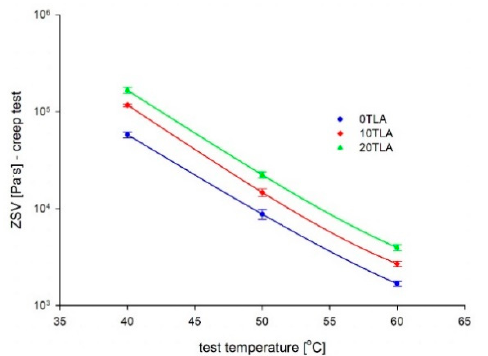
Figure 13. ZSV from creep test versus test temperature and TLA content on a semi-log plot.